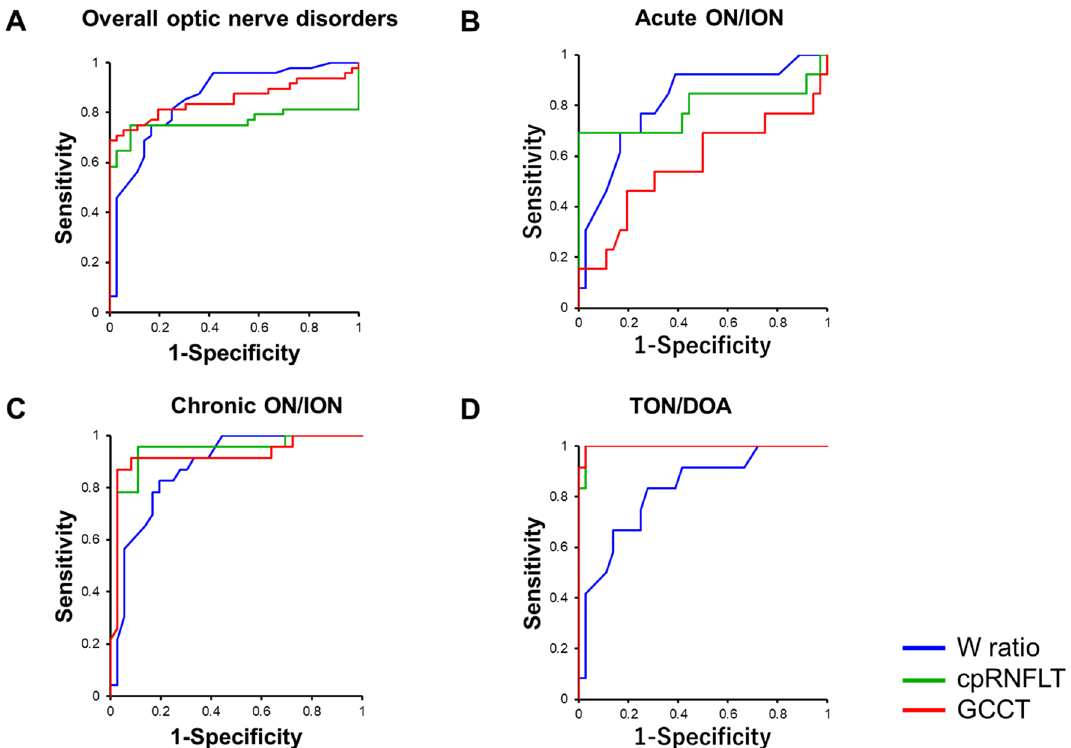
Figure 3. Receiver operating characteristic (ROC) curves for detecting optic nerve disorders. Blue, green, and red lines show the ROC curves for detecting optic nerve disorders using the W ratio , cpRNFLT and GCCT as indices respectively. ( A ). Overall optic nerve disorders, ( B ). Acute phase of optic neuritis or ischemic optic neuropathy, ( C ) chronic phase of optic neuritis or optic neuropathy, ( D ) hereditary or traumatic optic atrophy.